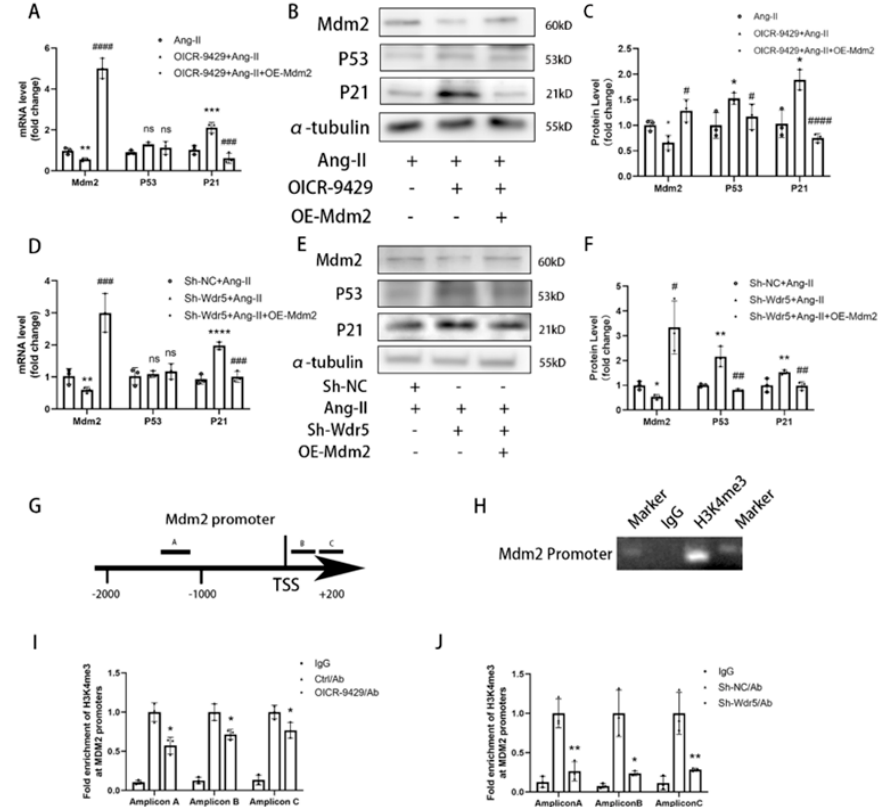
Figure 6. Inhibition of Wdr5 reduced the Mdm2/P53/P21 pathway. ( A ) Application of OICR9429 repressed the Mdm2 and p21 RNA levels. ( B ) Protein levels of P53 and P21 were upregulated after the application of OICR9429 and overexpressing Mdm2 inhibited the increasement. ( C ) is the quantitative analysis of graph ( B ). ( D ) Application of Sh-Wdr5 repressed the Mdm2 and P21 in mRNA levels. ( E ) Protein levels of P53 and P21 were upregulated after transfection of Sh-Wdr5 by lentivirus and overexpressing Mdm2 inhibited the increasement. ( F ) is the quantitative analysis of graph ( E ). ( G ) Schematic representation of the Mdm2 gene promoter containing the H3K4me3 enriched sites. TSS represented transcription start site. ( H ) Cut&Tag-PCR and southern blotting confirmed the enrichment of H3K4me3 on the promoters of Mdm2. ( I , J ) Cut&Tag-qPCR indicated the decreased enrichment fo H3K4me3 on the promoters of Mdm2 by 3 amplicons. Data are presented as mean ± SEM. * p < 0.05, ** p < 0.01, *** p < 0.001, **** p < 0.0001 vs. saline, # p < 0.05, ## p < 0.01, ### p < 0.001, #### p < 0.0001 vs. Ang-II